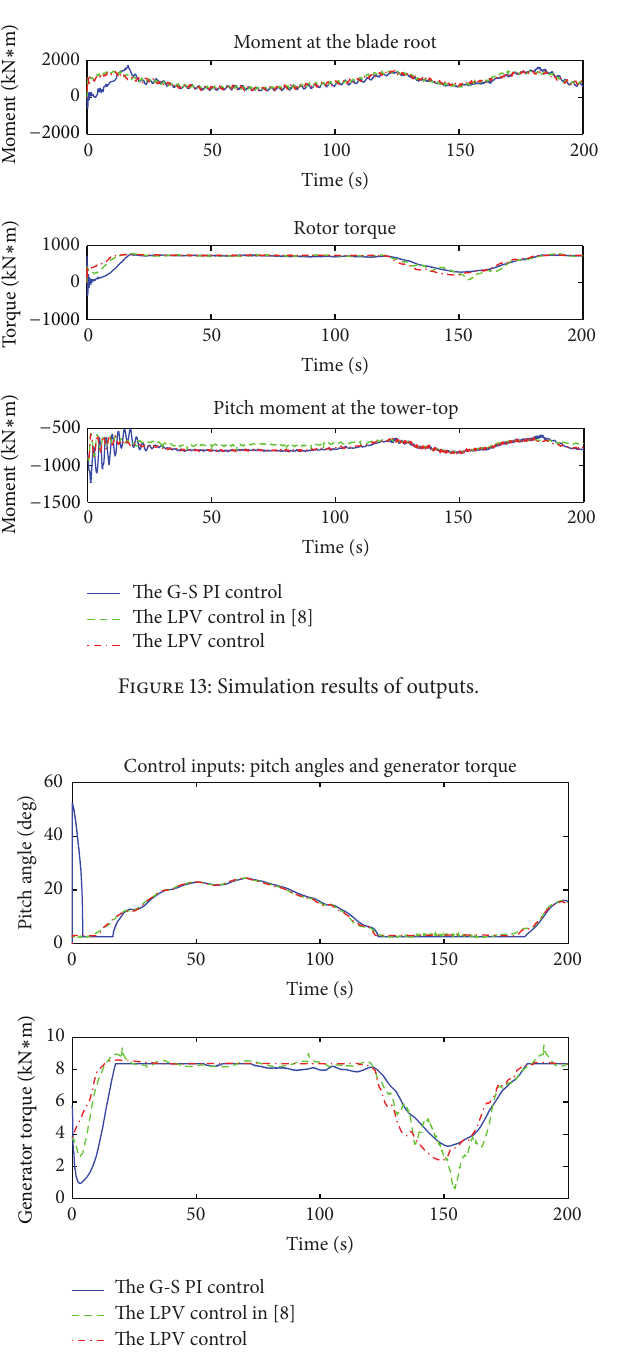
Figure 14: Simulation results of generator torque and pitch angles.